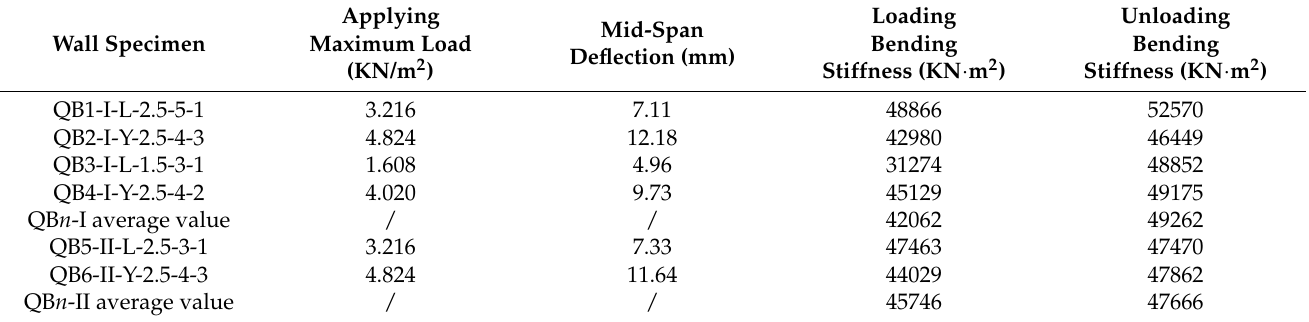
Table 5. The mid-span deflection and bending stiffness of LSF walls under maximum load.